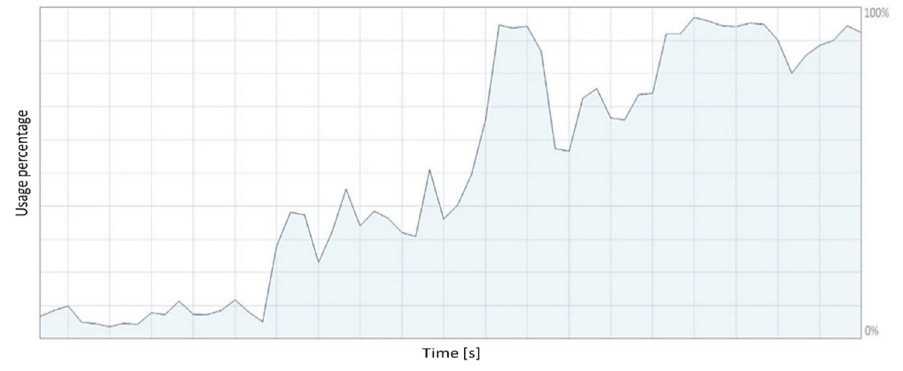
Figure 27. CPU performance.